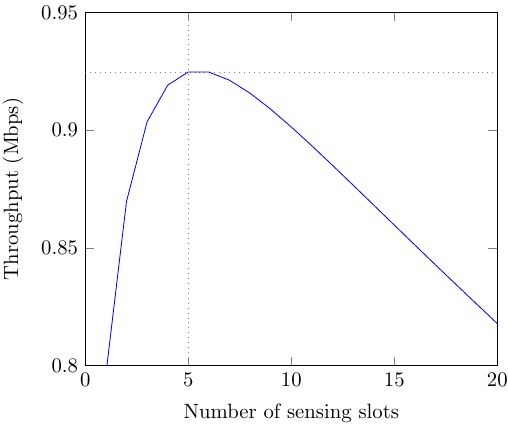
Figure 7. Number of sensing slots optimization.